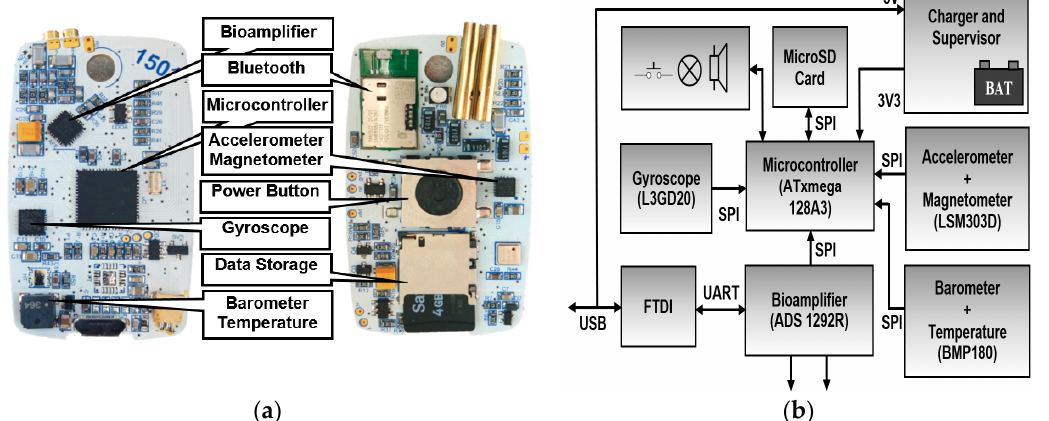
Figure 1. Electrocardiographic (ECG) Holter: ( a ) Printed circuit board (PCB) layout, ( b ) block diagram.